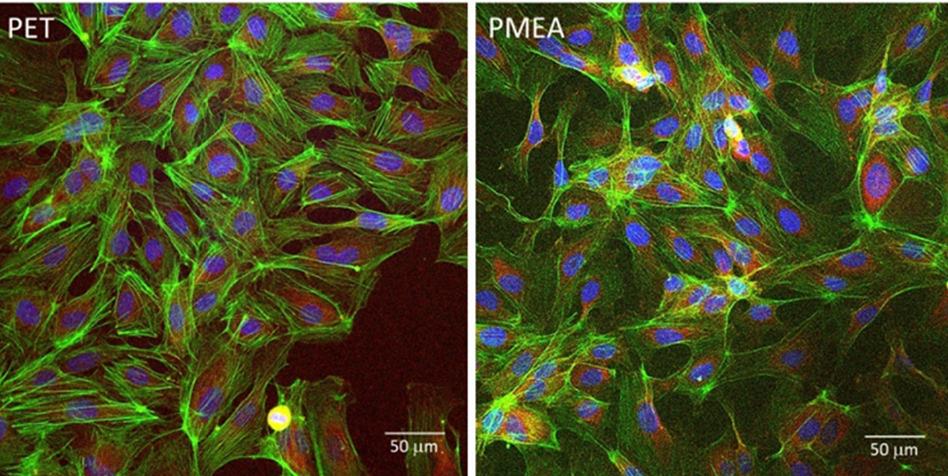
Figure 9. CLSM images of HUVECs cultured on PET and PMEA-coated surface. Blue: Cell nuclei; green: vinculin; red: actin fiber .